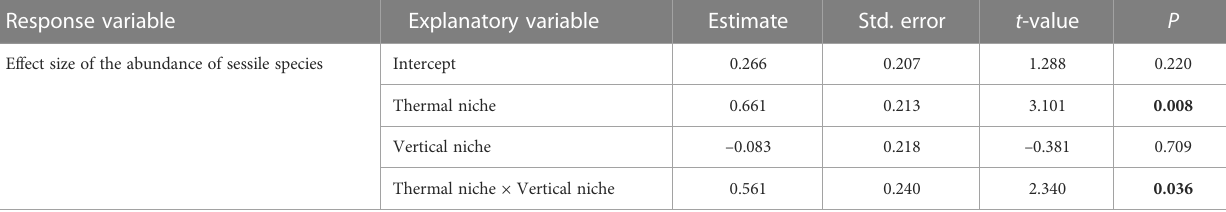
TABLE 6 Results of multiple regressionanalysis testing how theeffects of MHWs onthe abundance ofeachsessilespecies ofrockyintertidalorganism (macroalgaeandsessile invertebrates) in2016 (i.e.,consideringthe accumulativecarryover effect) differ depending on thermalandverticalniches. Response variable